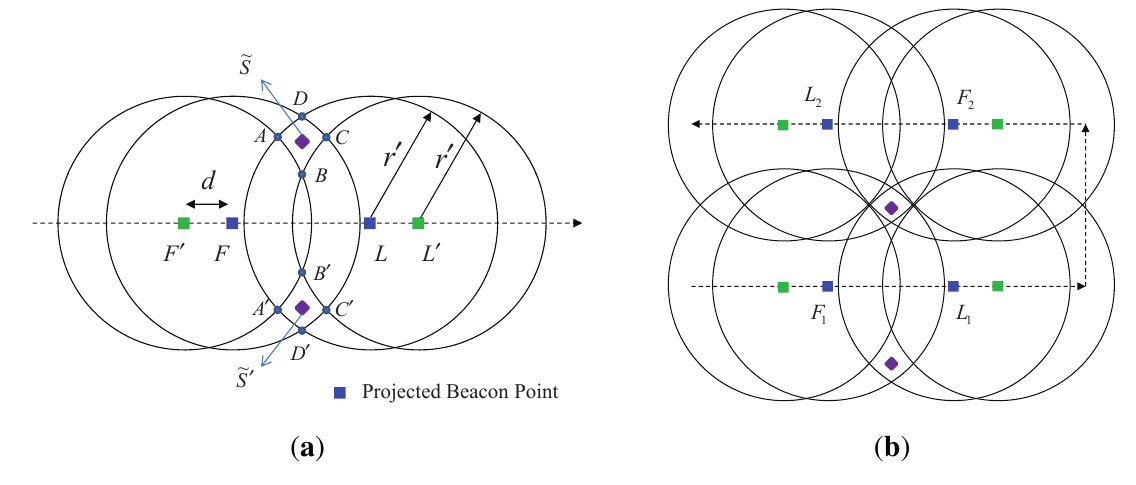
Figure 3. Location estimation with projected beacon points based on geometric